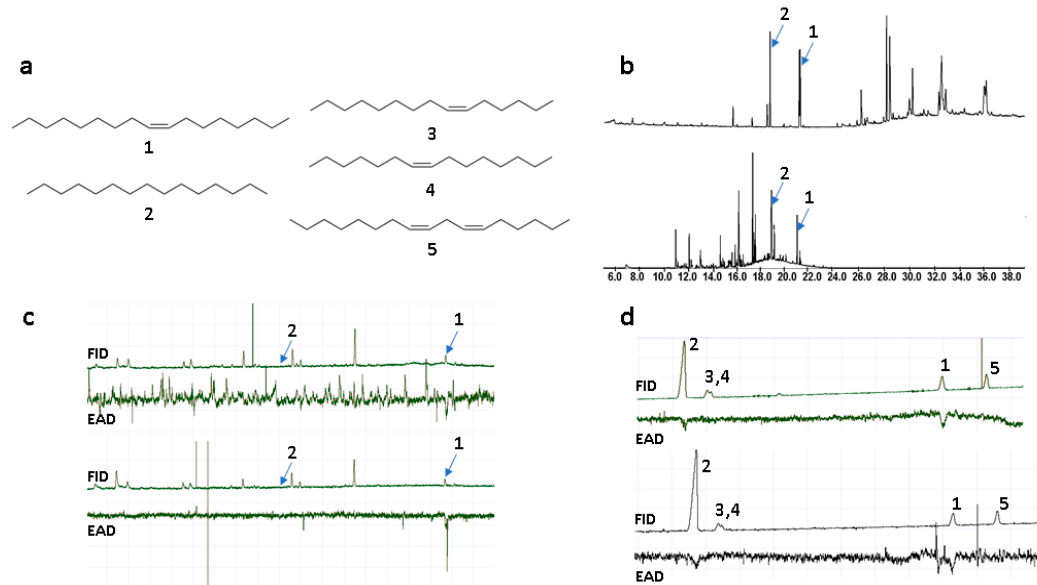
Figure 1. ( a ) Semiochemicals from Ophrys insectifera ( 1 – 2 ; 1 = ( Z )-8-heptadecene, 2 = n -pentadecane) and female Argogorytes mystaceus ( 1 – 5 ; 3 = ( Z )-6-pentadecene, 4 = ( Z )-7-pentadecene, 5 = ( Z , Z )-6,9-heptadecadiene). ( b ) GC-MS total ion chromatograms of female A. fargeii (upper trace) and O. insectifera (lower trace). ( c ) GC-EAD of SPME extracts of O. insectifera to antenna of A. mystaceus males. Two replicated analyses are shown. ( d ) GC-EAD of synthetic standards 1 ‒ 5 to antenna of A. mystaceus . Two replicated analyses are shown.